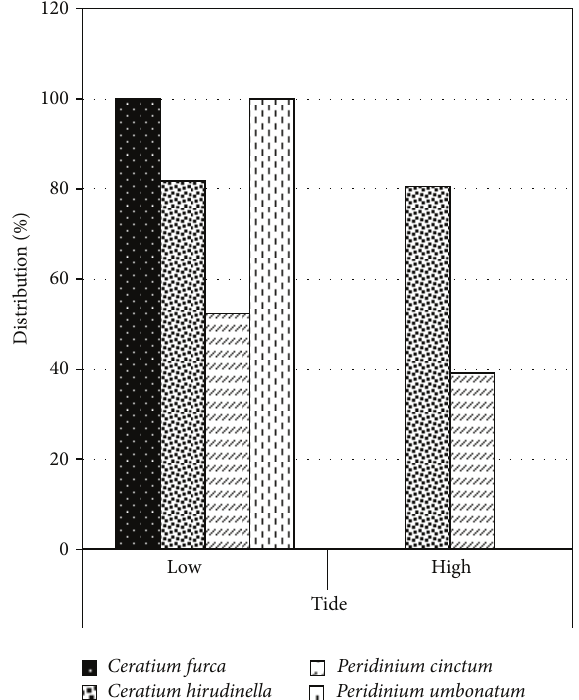
Figure 13: Variation of Pyrrophyceae species in relation to tide in Okpoka Creek.